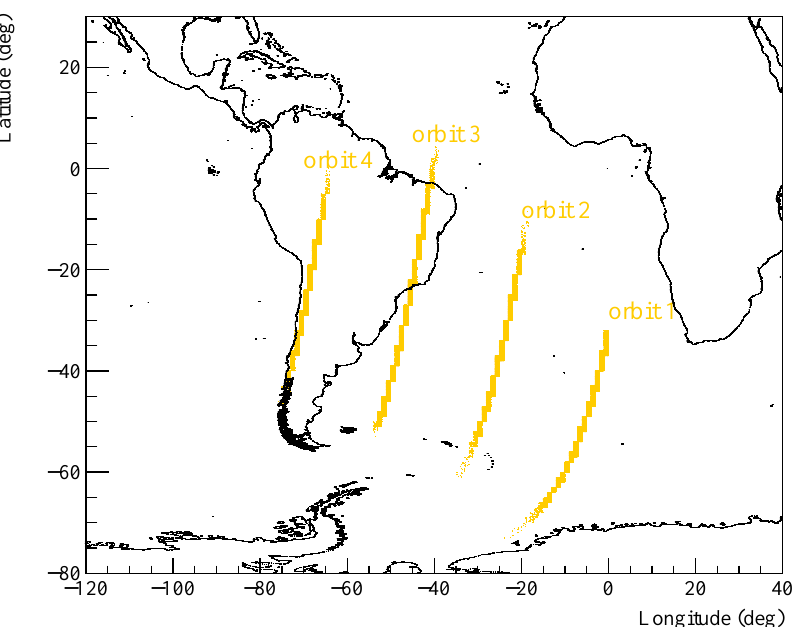
Figure 3. Representation of the four orbits chosen for the time-profile evaluation as a function of geographical latitude and longitude; orbit 1 appears to be more peripheral with respect to, for example, orbit